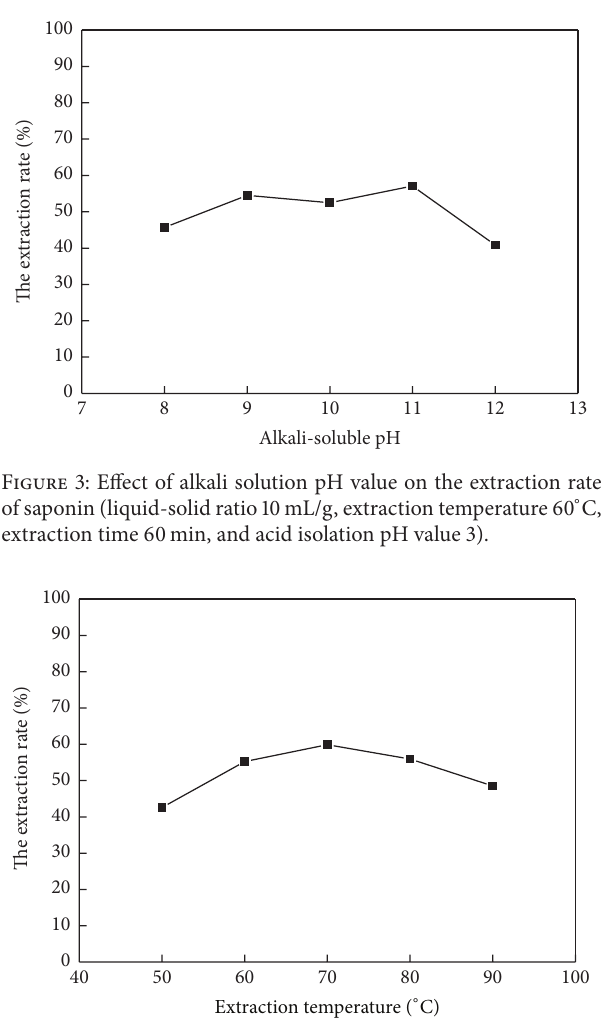
Figure 4: Effects of extraction temperature on the extraction rate of saponin (liquid-solid ratio 10 mL/g, alkali solution pH value 10, extraction time 60 min, and acid isolation pH value 3).